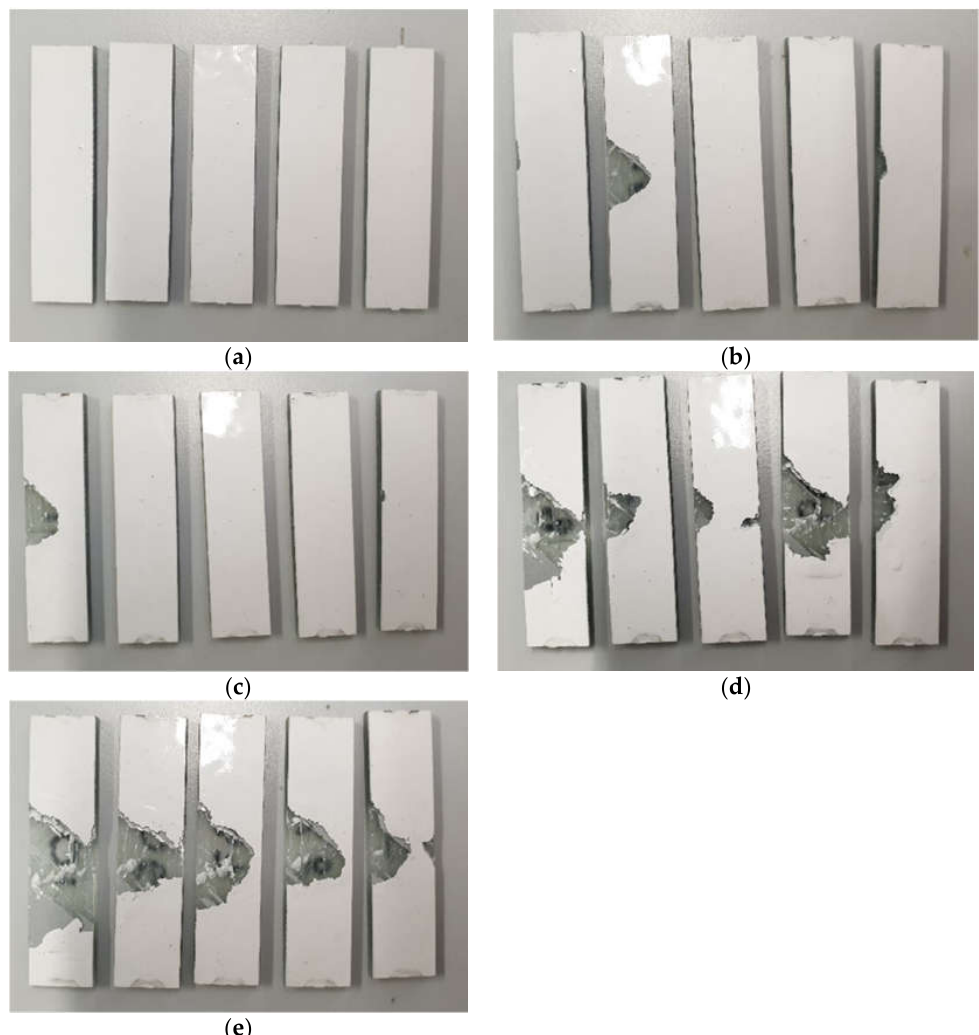
Figure 7. ( a ) Samples with coating B at stage 1; ( b ) samples with coating B at stage 2; ( c ) samples with coating B at stage 3; ( d ) samples with coating B at stage 4; ( e ) samples with coating B at stage 5. Figure 8 presents images of five individual specimens with coating C after each ero- sion stage.